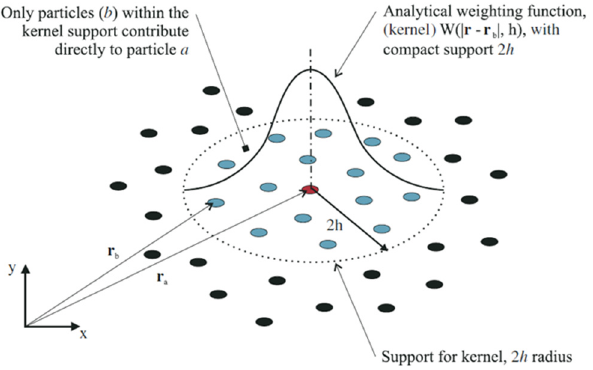
Figure 2. Schematic representation of a typical kernel. Reprinted with permission from Cummins et al. [37]. Copyright 2022 John Wiley and Sons.